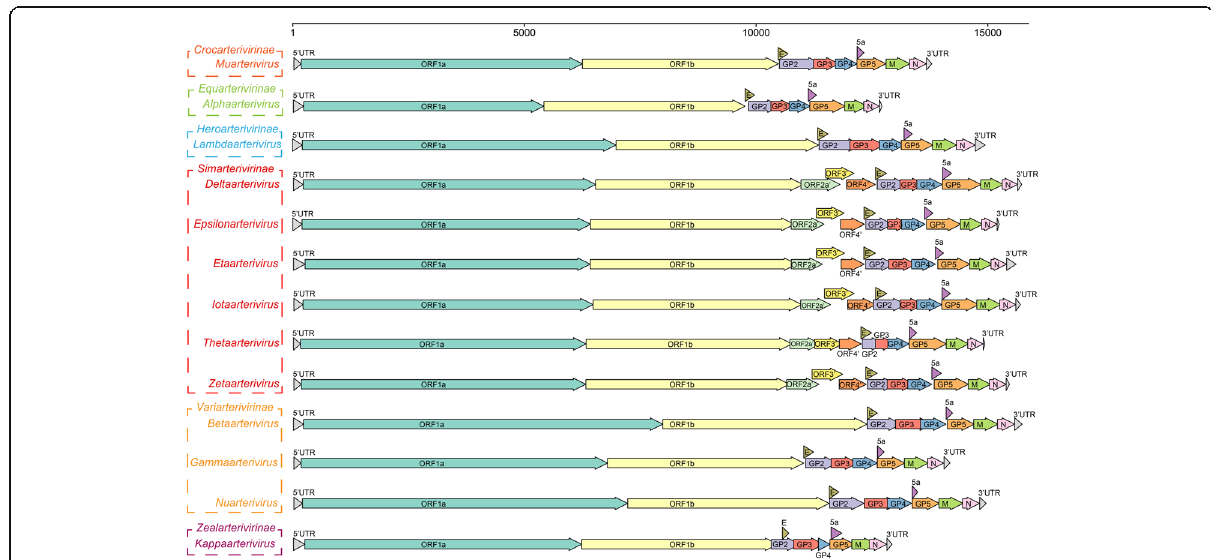
Fig. 6 Gene composition of viruses in 13 viral genera in Arteriviridae . The reference strains used for mapping in each genus are as follows: Muarterivirus (Olivier's shrew virus 1 , NC_035127.1), Alphaarterivirus (Equine arteritis virus, NC_002532.2), Lambdaarterivirus (Forest pouched giant rat arterivirus, NC_026439.1), Deltaarterivirus (Simian hemorrhagic fever virus, NC_003092.2), Epsilonarterivirus (Free State vervet virus, NC_029992.1), Etaarterivirus (Kibale red colobus virus 2, NC_034455.1), Iotaarterivirus (DeBrazzas monkey arterivirus, NC_026509.1), Thetaarterivirus (Kafue kinda chacma baboon virus, NC_029053.1), Zetaarterivirus (Kibale red colobus virus 1, NC_033553.1), Betaarterivirus (Rat arterivirus 1, NC_028963.1), Gammaarterivirus (Lactate dehydrogenase-elevating virus, NC_001639.1), Nuarterivirus (Rodent arterivirus, KY369969.1), Kappaarterivirus (Wobbly possum disease virus,